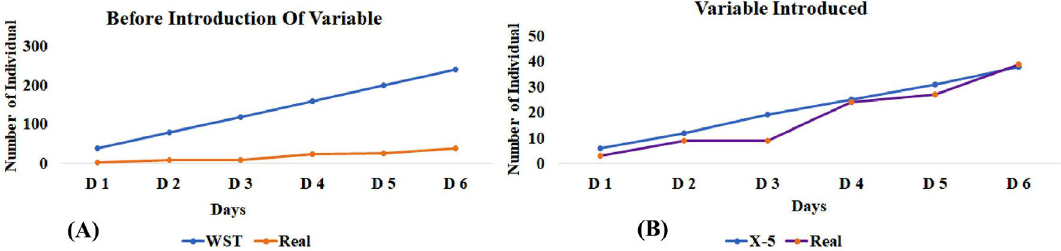
Figure 5. ( A ) Graph representing the number of individuals (Y-axis) found at each day (X-axis) with 1-h adjustment. Blue graph line indicates the number of individuals that will be available. In the real situation, we will never get so many samples because of individuals are avoiding medical treatment for a range of reasons thus the sample number deviate from the calculated samples. ( B ) Introduction of variables (X1, X2, X3, X4, X5) and uniform distribution of patients in these five different categories leads to minimum bias ( WST without